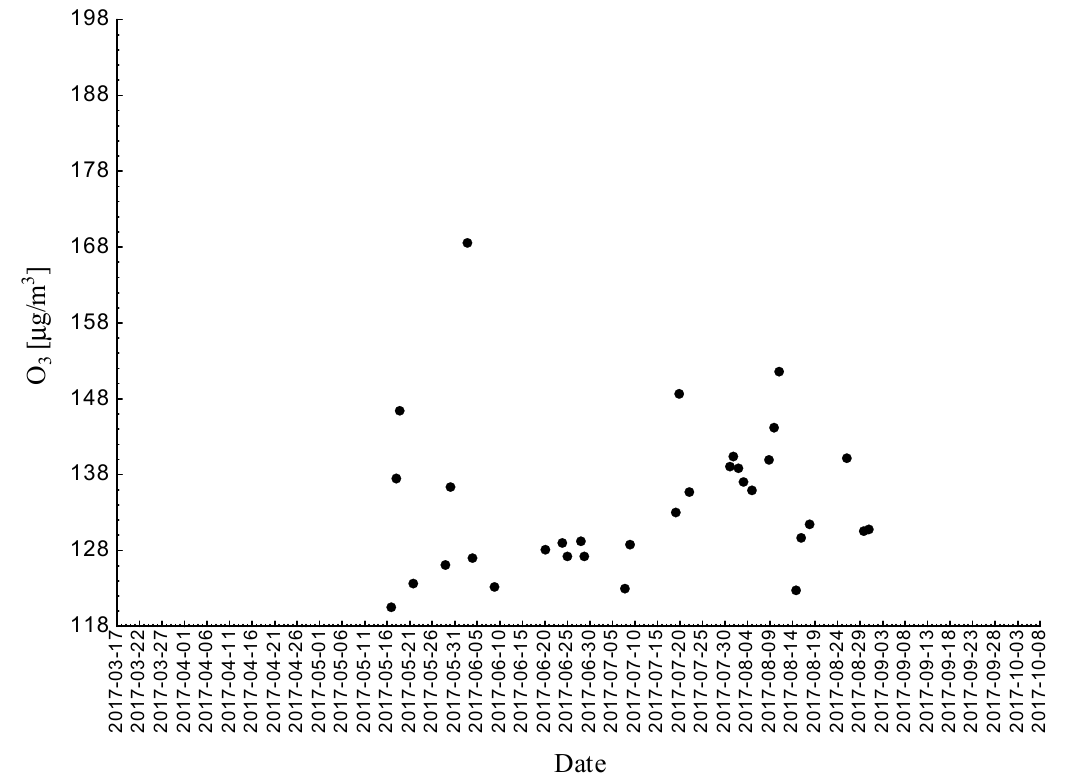
Figure 7. Maximum daily 8-h mean ozone concentration not less (equal to or more than) than 120.4 µg/m registered at the measurement station in Katowice (SL09KA) in 2017.